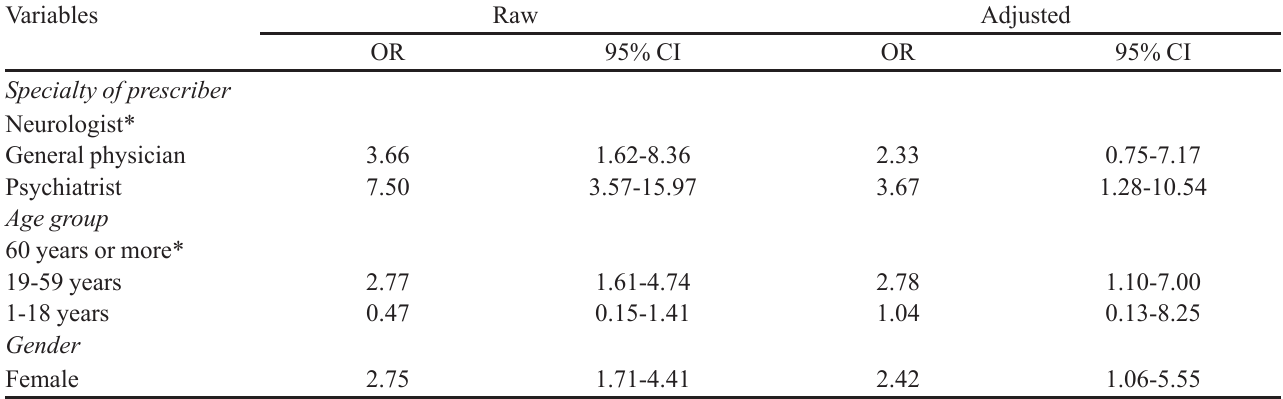
TABLE IV - Results of the multivariate analysis of determinants for prescribing antidepressants purchased from the Pharmacy of the Civil Servants’ Clinic (CLISERV) of the Municipal Government of Belo Horizonte, Minas Gerais, Brazil, 2005